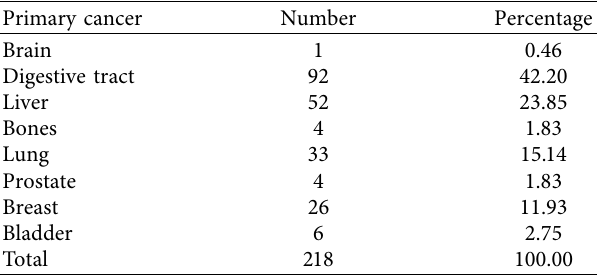
Table 2: Distribution of patients by the type of primary cancer.